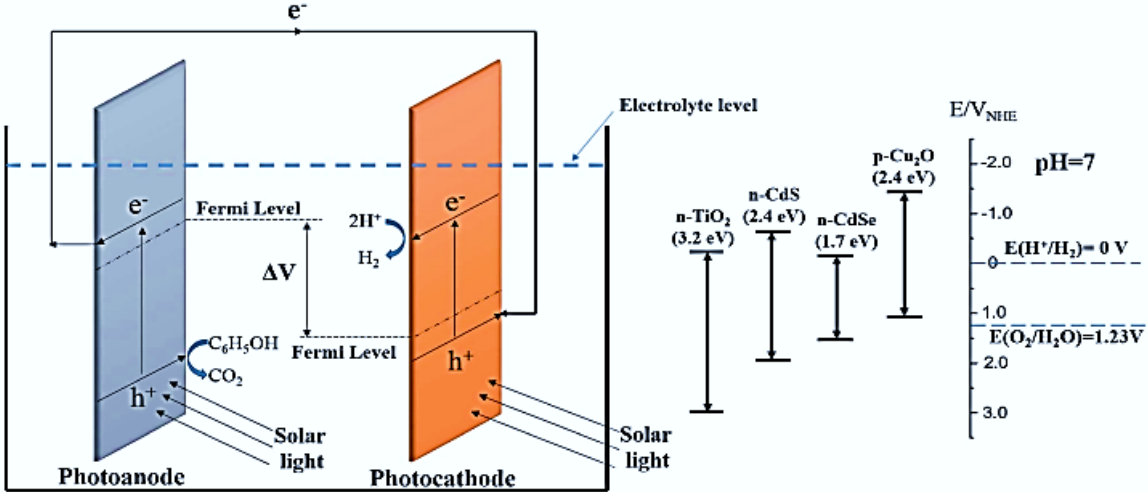
Figure 3. A working diagram of PFC system. Adopted with the permission from Ref. [34]. Copyright The Royal Society of Chemistry 2014.